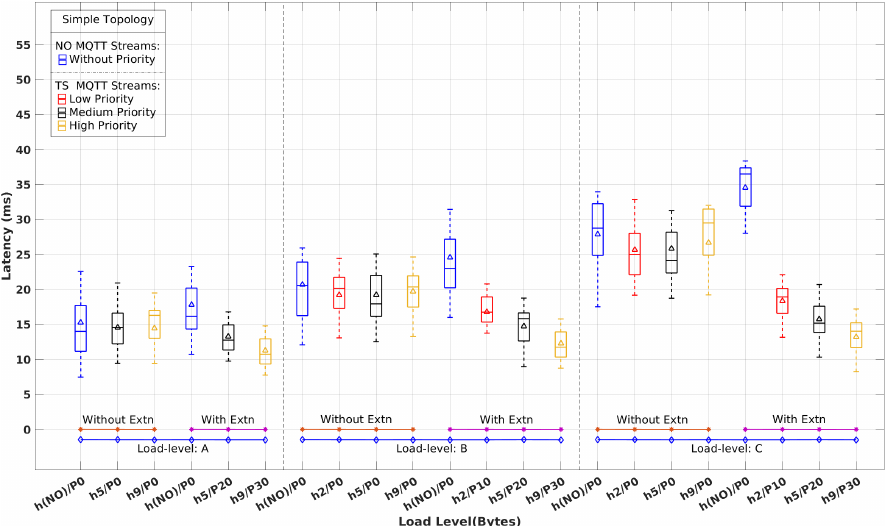
Figure 13. Latency of time-sensitive vs. normal MQTT flows with and without real-time extensions for the Simple topology physical implementation with load levels A, B, and C.